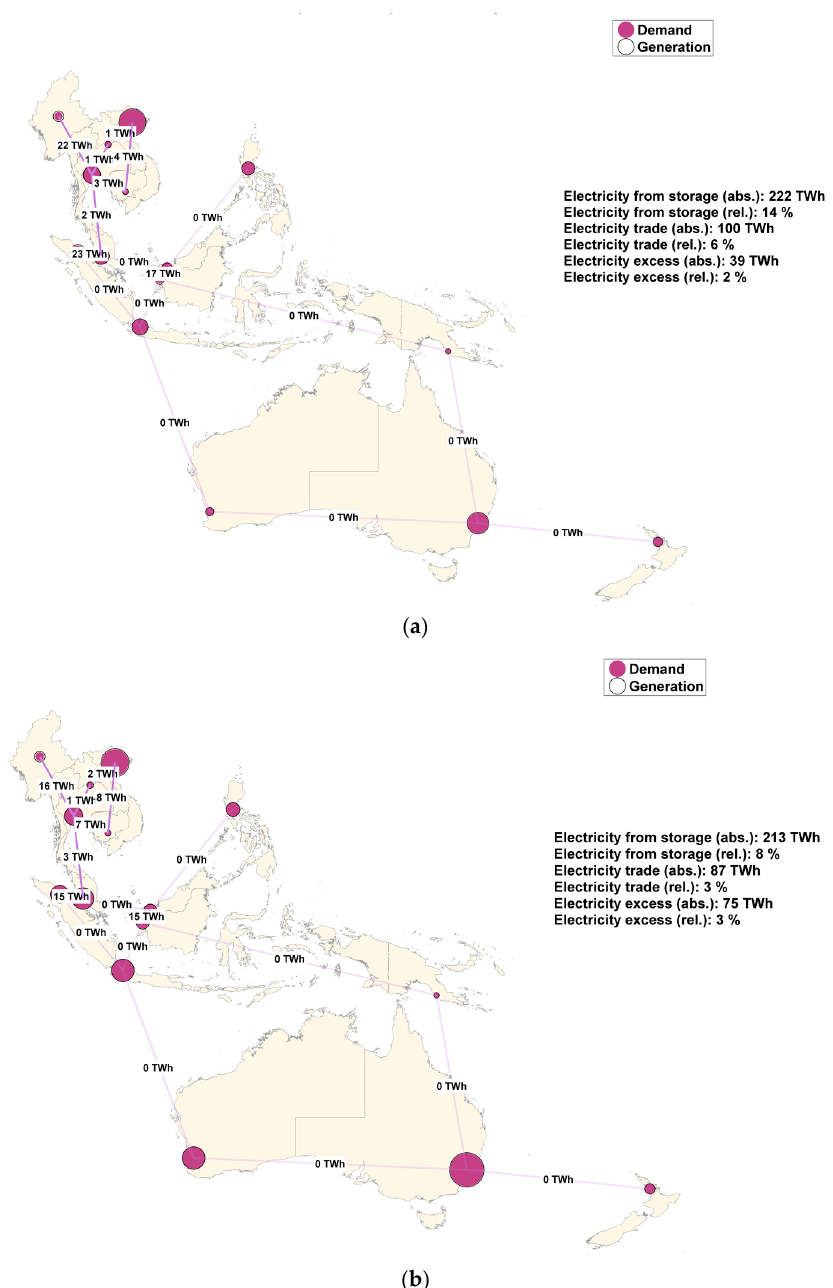
Figure 6. Annual import and export of electricity diagrams for: ( a ) area-wide; and ( b ) integrated scenario.